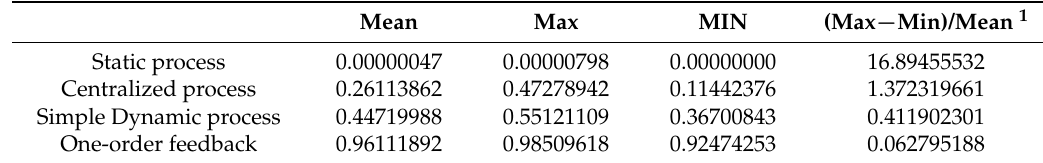
Table 4. Robustness on reliability of four